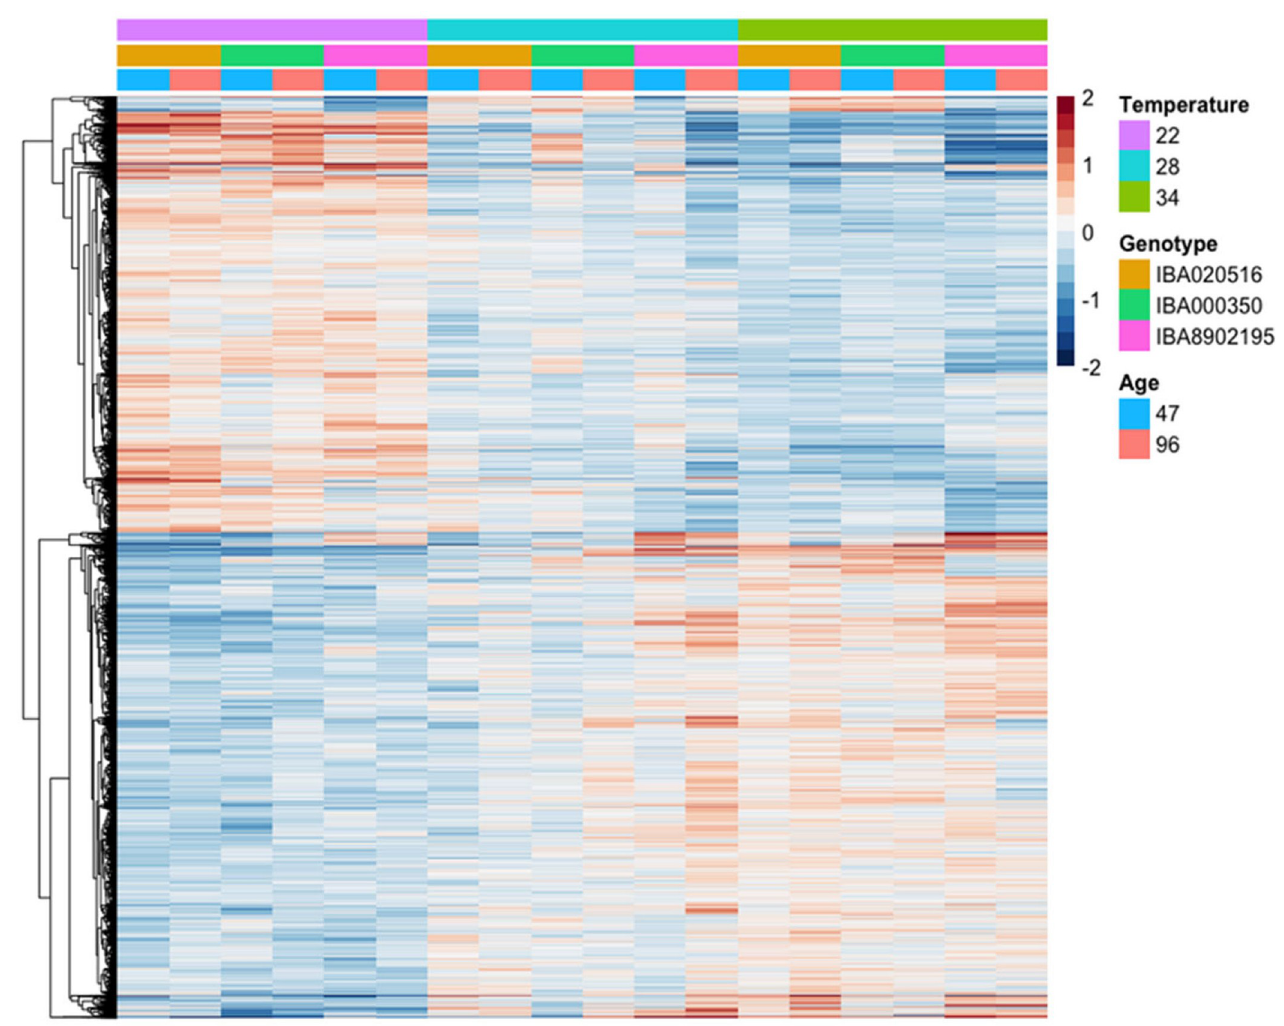
Fig 10. Relative expression (log 2 scale) of differentially expressed genes in response to controlled-environment temperature (22, 28 or 34˚C), genotype (‘516, ‘350, ‘2195), and timepoint of development (47 and 96 DAP). The figure shows 7253 genes differentially expressed (p adj � 0.05) (averages of biological replicates per time point, genotype and location). Color scale indicates log 2 fold changes. Legend in header indicates color coding of